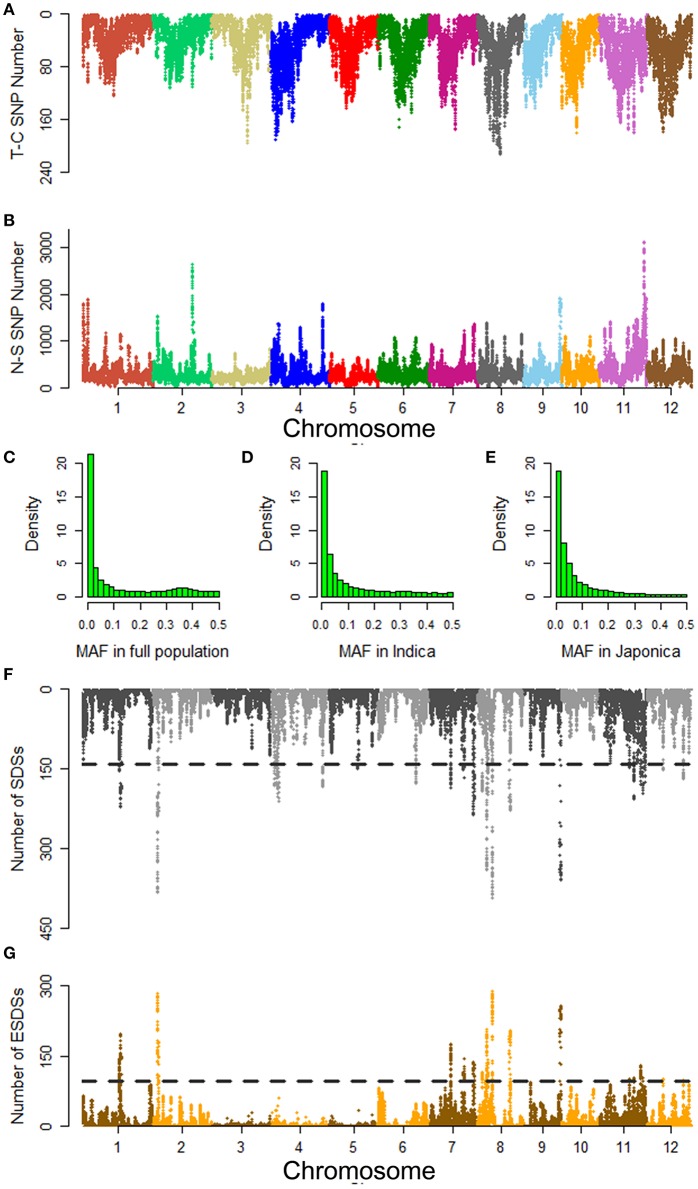
Summary of non-synonymous SNPs detected in the full population and their distribution associated with mesocotyl length in the indica genome. (A) Termination codon SNP (T-C SNP) along the genome. (B) Non-synonymous SNPs (N-S SNP) along the genome. Histograms of minor allele frequencies (MAFs) of non-synonymous SNPs in the (C) full population, (D)
indica, and (E)
japonica. Distributions of (F) SDSs and (G) ESDSs along the indica genome. SDS and ESDS show SNPs with significant and extremely significant differences (p < 0.05; p < 0.01) in allele frequency between polar pools. For each 500 kb sliding window, the numbers of SDSs and ESDSs were plotted on the entire genome. The sliding step is 50 kb. Adjacent chromosomes are delineated using different colors. Horizontal black lines show the thresholds for the 99th percentile of 10,000 permutations of the SDS and ESDS numbers.